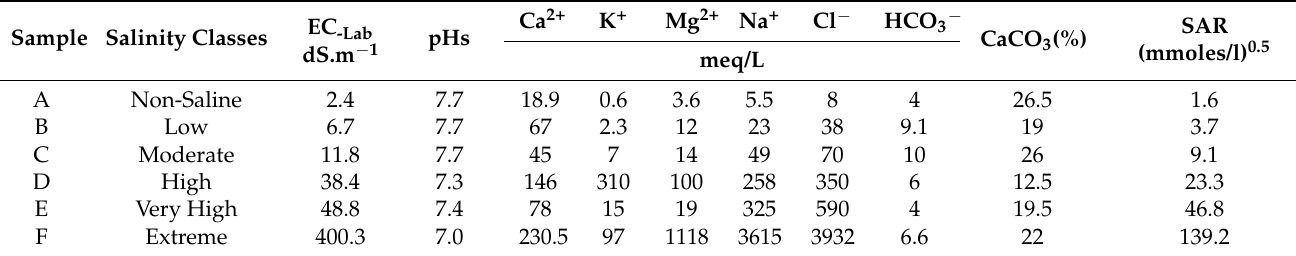
Table 1. Laboratory analysis of the six soil classes that are presented in Figures 3 and 5. Sample Salinity